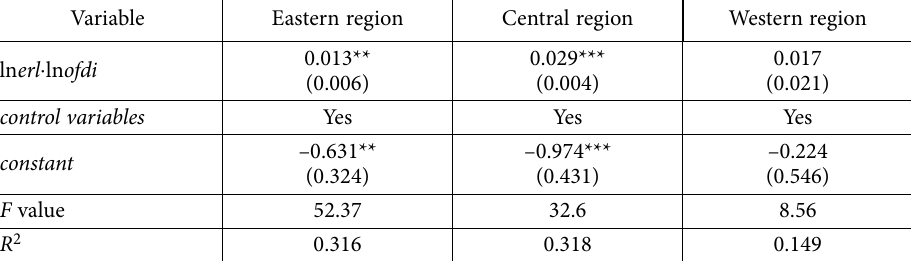
Table 8. Effect of outward foreign direct investment (source: The data in the table are calculated by the software of STATA) Variable Eastern region Central